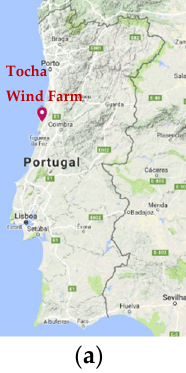
Figure 3. Tocha Wind Farm: ( a ) geographic location in Portugal; ( b ) wind turbines and auxiliary structures; and ( c ) characterization of the wind conditions observed between 2013 and 2018, based on data provided by meteorological mast (100 m high measurements).